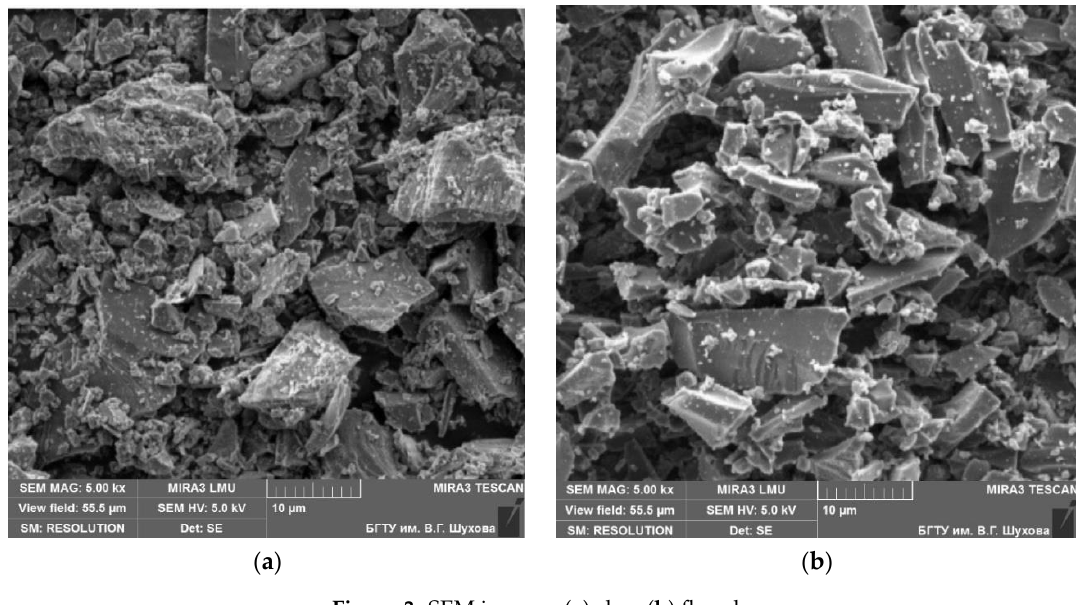
Figure 3. SEM images: ( a ) slag, ( b ) fly ash.